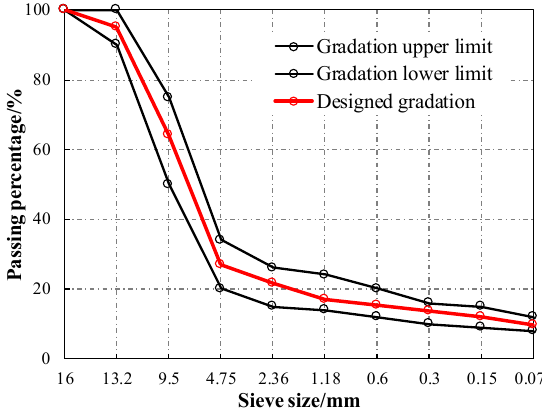
Figure 3. Designed gradation of CASMA-13 and SMA-13.